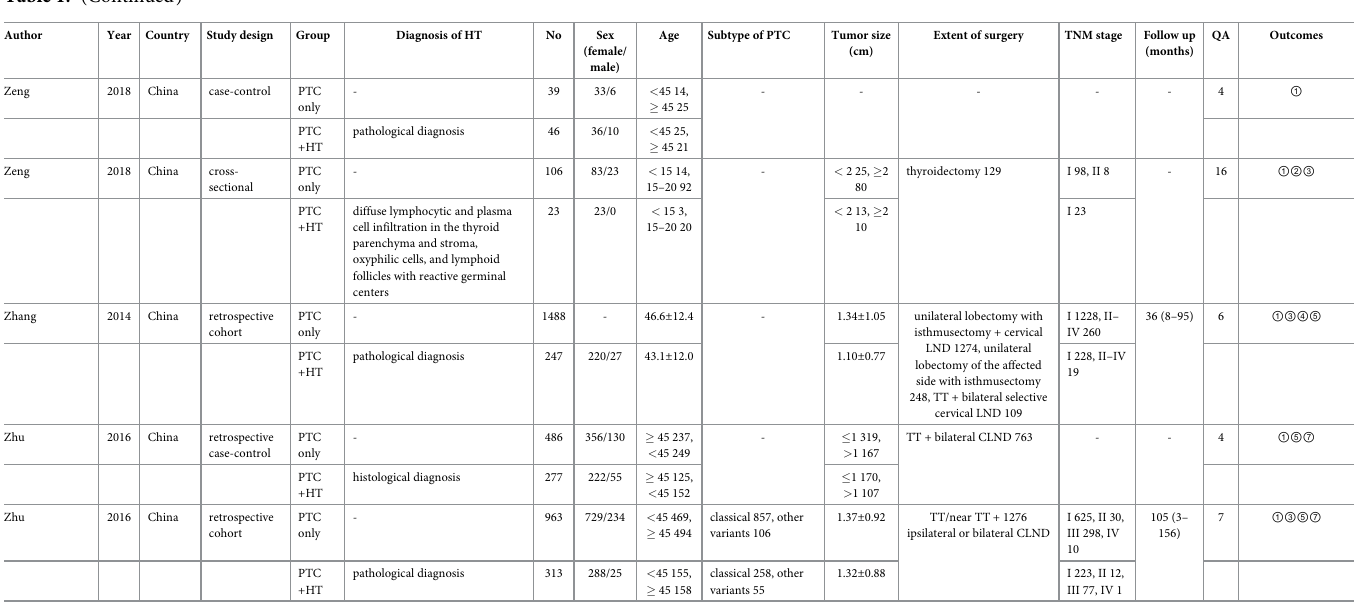
Extrathyroidal extension. Totally 41 studies covering 13940 patients identified the associ- ation between HT and clinical outcome of PTC. The heterogeneity test results were statistically significant (I 2 = 74.1%), so the random-effect model was utilized. The result revealed that the risk of extrathyroidal extension in the HT group was lower than that in the non-HT group (OR: 0.745, 95%CI: 0.657–0.845, P < 0.001) (Table 2, Fig 4). Recurrence. Sixteen studies containing 577 patients have assessed the recurrence. The result of fixed-effects model demonstrated that HT could decrease the risk of recurrence in PCT (OR: 0.627, 95%CI: 0.483–0.813, P < 0.001) (Table 2, Fig 5). Multifocality. Multifocality referred to two or more foci found in the same lobe of the gland. A total of 44 studies embracing 10320 were included to evaluate multifocality. The het- erogeneity test results were statistically significant (I 2 = 61.3%), so the random-effects model was used. The result illustrated that that the HT group had a higher risk of multifocality than the non-HT group (OR: 1.245, 95%CI: 1.132–1.368, P < 0.001) (Table 2).